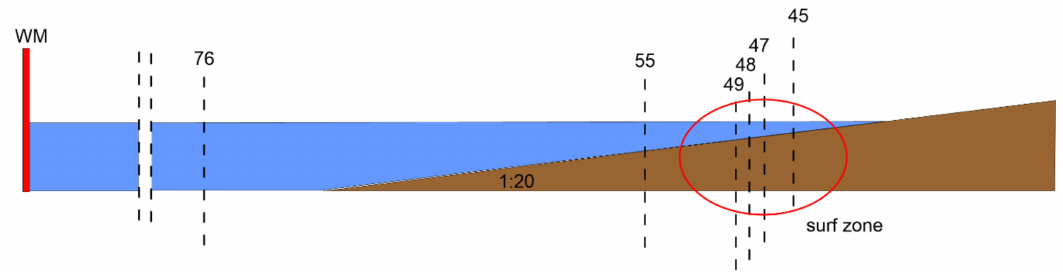
Figure 2. Sketch of the channel with indications of the investigated sections used to calibrate the numerical